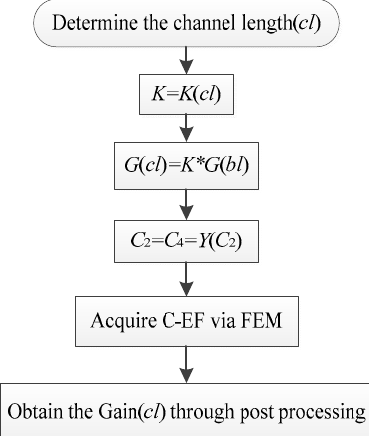
Figure 7. The flow chart of the short distance intra-body communication channel characteristics estimated in Field-Circuit model.